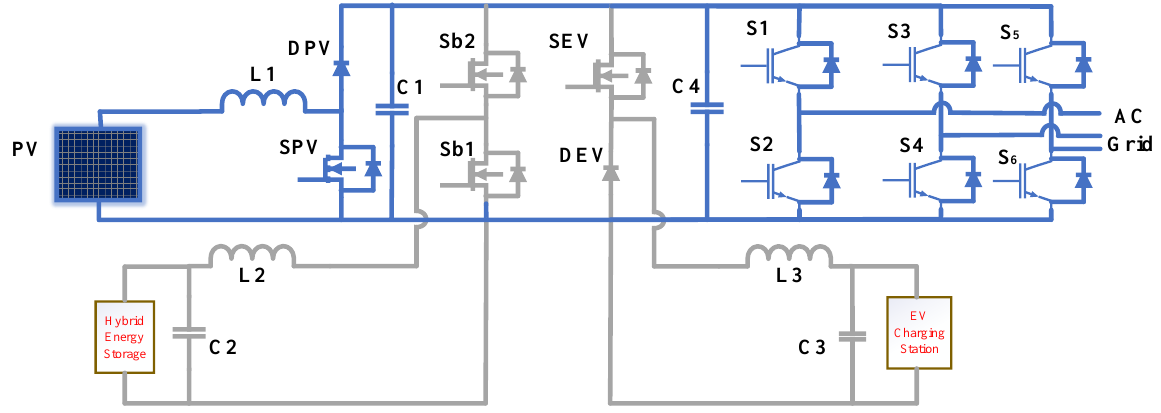
Figure 9. Power flow from Grid to EV Charging station.